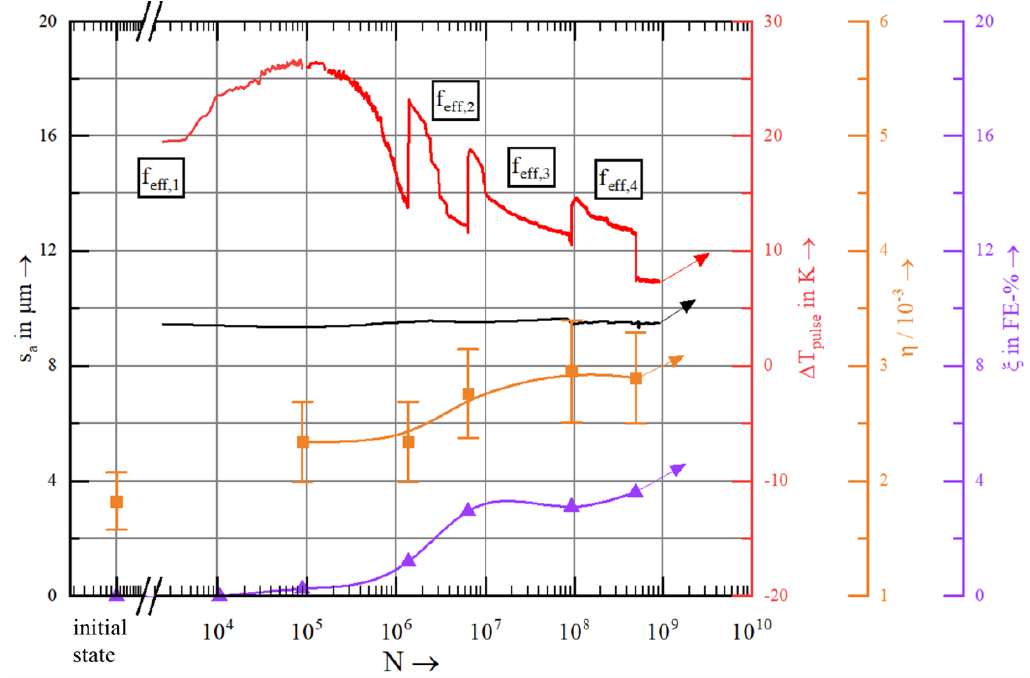
Figure 8. Development maximum displacement amplitude (s a ), change in temperature during each load pulse ( ∆ T pulse ) and the quasi in-situ measured magnetic phase fraction( ξ ) as well as the loss coefficient factor ( ) during ultrasonic fatigue testing with σ a = 250 MPa at ambient temperature of AISI 347 .